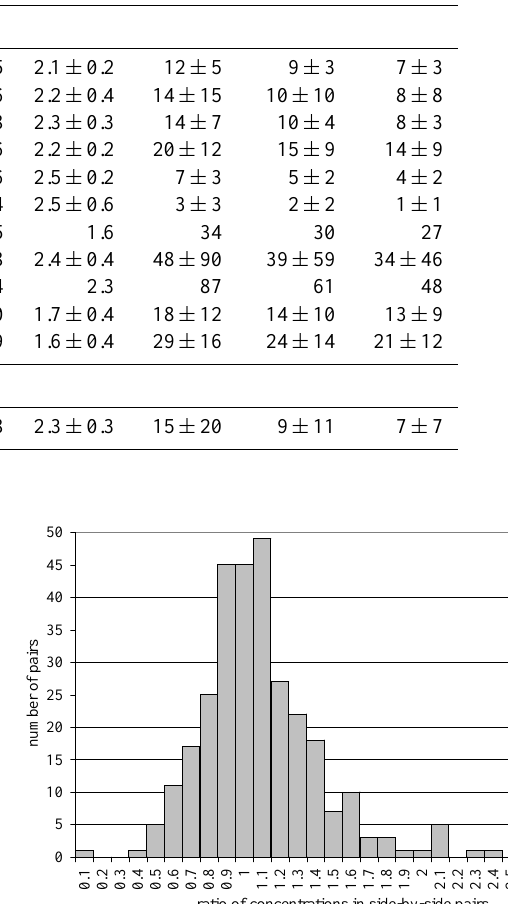
˚A tot C equiv f est C max C est nonBC BC BC BC (%) (ngg − 1 ) ( ngg − 1 ) (ngg − 1 )